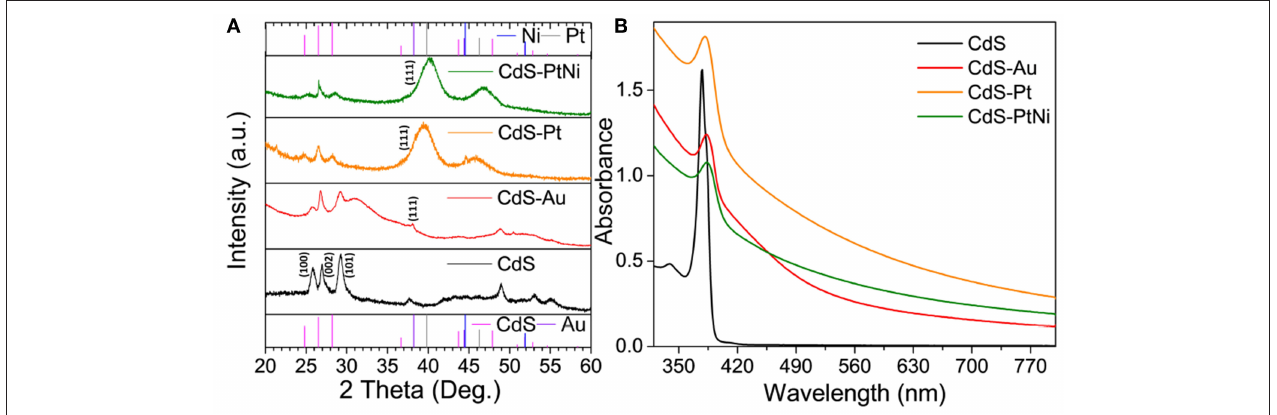
FIGURE 2 | (A) XRD patterns and (B) UV-vis spectra of pristine CdS NPLs and CdS–M HNSs. JCPDS numbers of CdS, Au, Pt, and Ni literature patterns in panel A are 41-1049, 04-0784, 04-0802, and 04-0850, respectively. The broad peak around 30 ◦ in the CdS–Au diffraction pattern may be attributed to the presence of